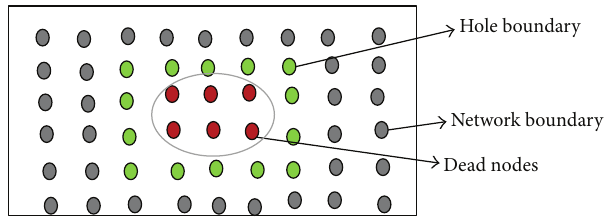
Figure 1: Hole and its